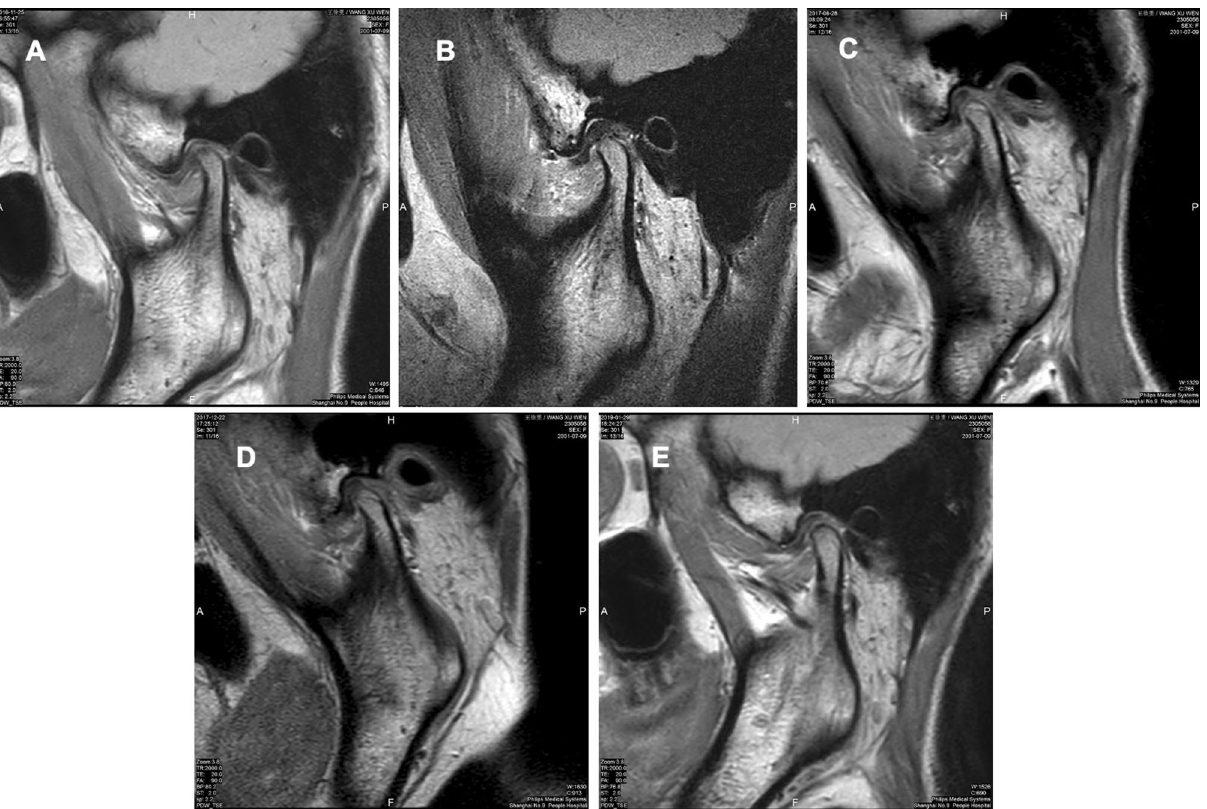
Figure 2. Typical case of new bone formation. ( A ) Pre-operative MRI showed TMJ ADDWoR. ( B ) Post- operative MRI showed well repositioned TMJ disc. ( C ) 6 months post-operatively, the disc was replaced and new bone was formed on the posterior slope of condyle. ( D ) 12 months post-operatively, newly formed bone reconstructed with the condyle. ( E ) 24 months post-operatively, the border between new bone and condyle vanished, the condyle was well